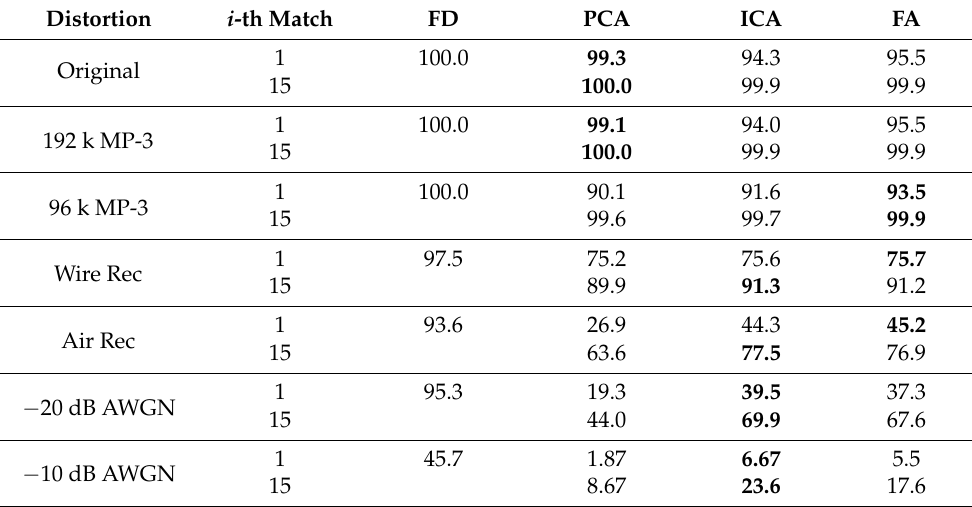
Table 2. Identification accuracy for various